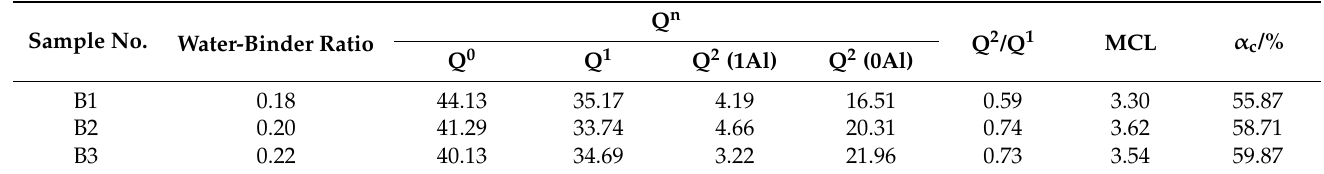
Figure 7. The 29 Si NMR spectra of arched shell interface transition zone in specimens B1–B3 after 28 days curing time. Table 5. The 29 Si NMR deconvolution results of arched shell interface transition zone in specimens B1–B3 after 28 days curing